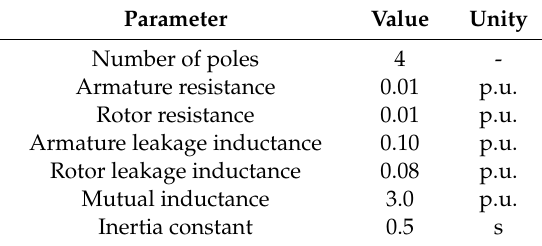
Table 1. Parameters of the Electromagnetic Frequency Regulator.